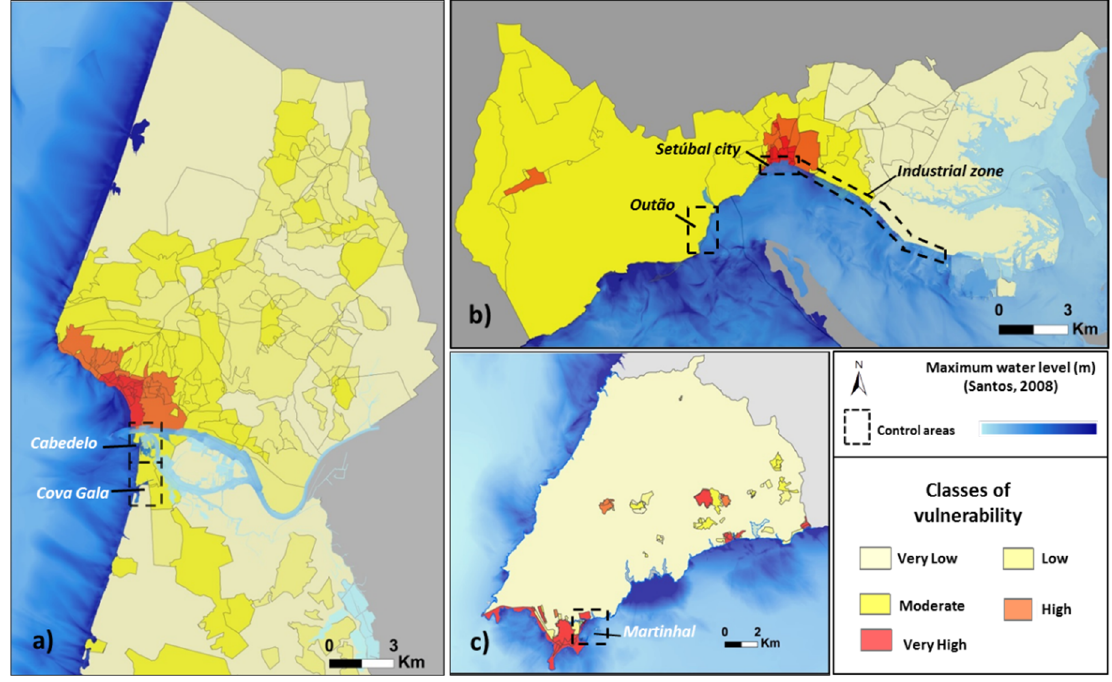
Figure 13. Social vulnerability: ( a ) Figueira da foz municipality; ( b ) Setúbal municipality; and ( c ) Vila do Bispo